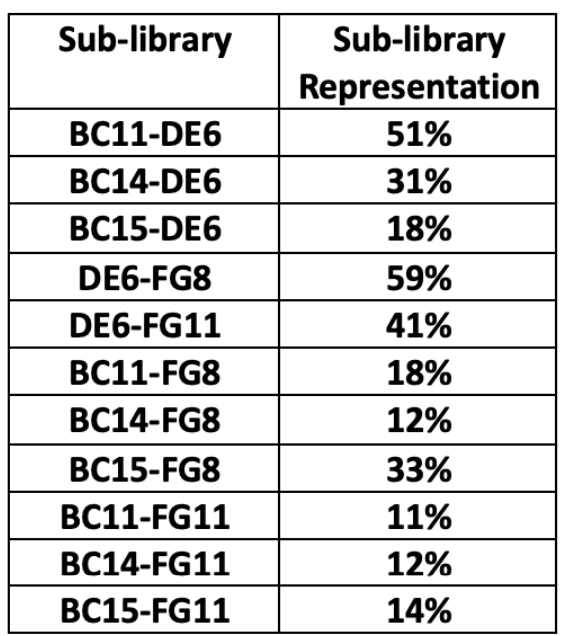
Figure 2. ( A ) Phagemid vector used for the Pronectin Fibronectin Universal Libraries. ( B ) The PCA assembly of the FN3 scaffold using oligonucleotides with 15 base pairs of overlapping homology. ( C ) Summary of the diversity of the three two-loop Pronectin Universal Fibronectin Libraries. The Pronectin Universal Fibronectin Libraries contains 25 billion variants. ( D ) The percentage of each sub-library for the three 2-loop libraries with their varying loop lengths.